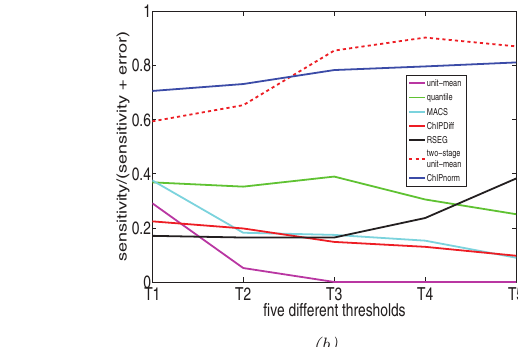
two-stage unit-mean